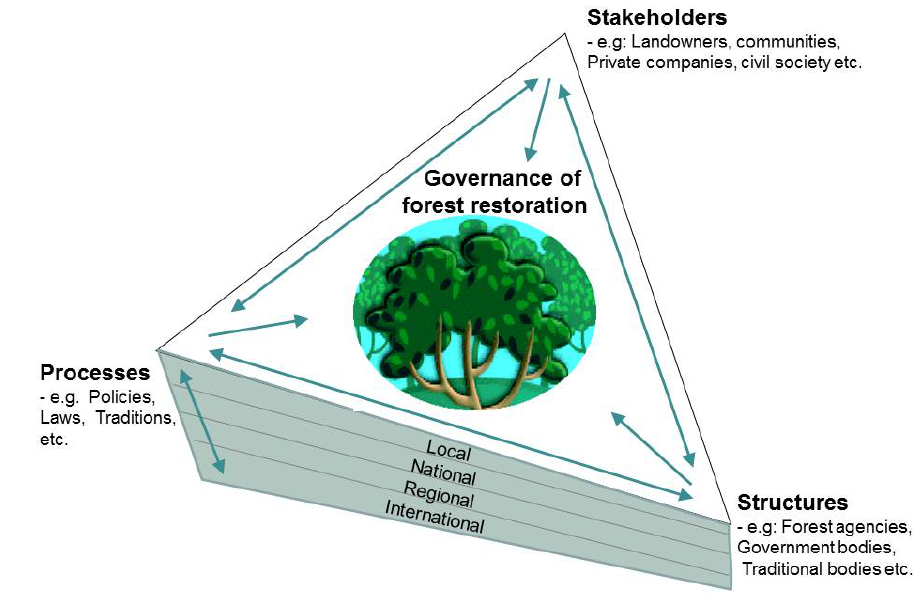
Figure 1. Framework to Assess the Governance of Forest Restoration (adapted from